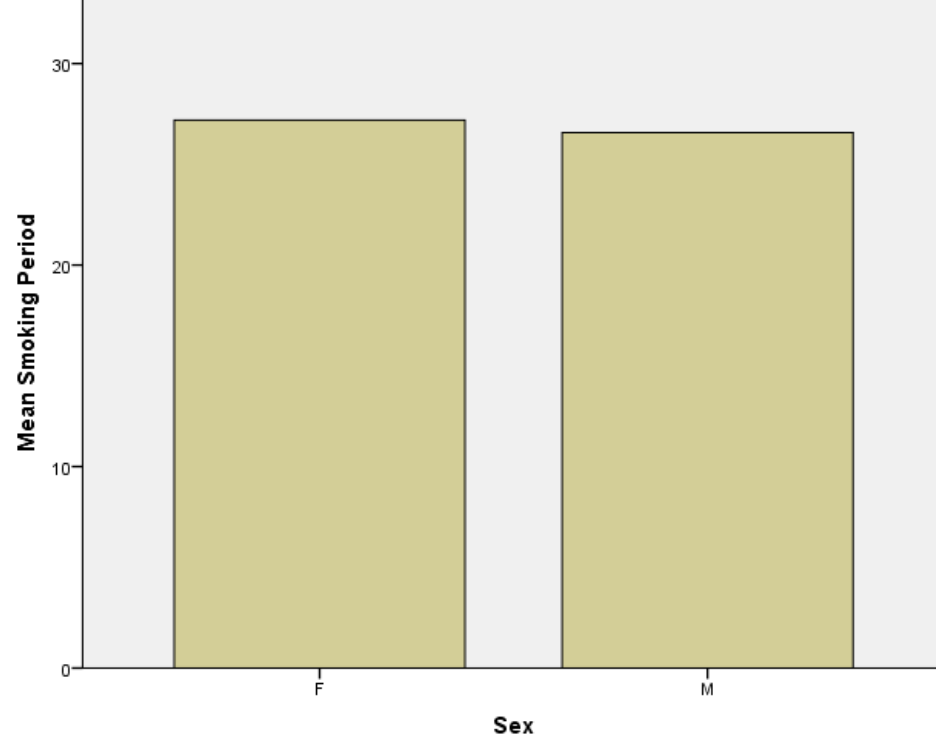
Figure 5. Smoking period in females (F) and males (M) subgroups.